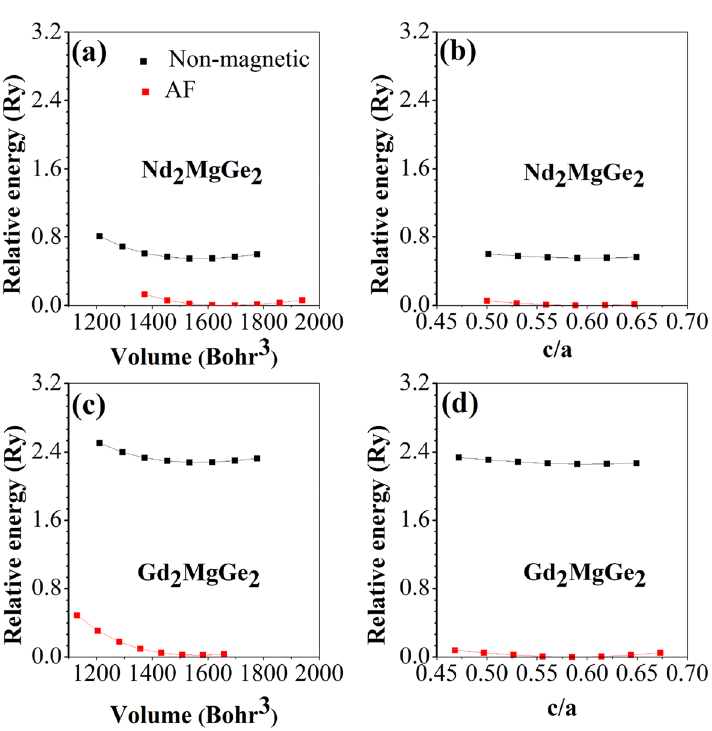
Figure 2. Total energy ( a , c ) versus volume and ( b , d ) versus c / a